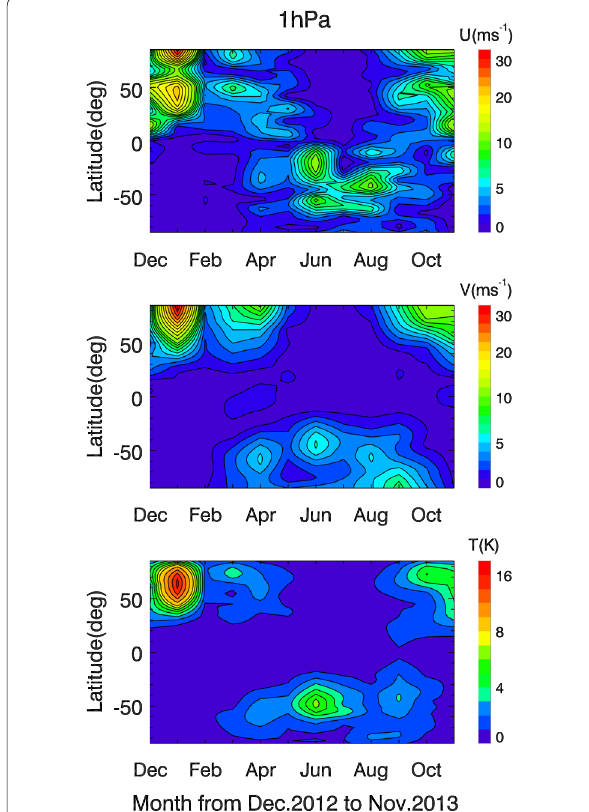
Fig. 3 Latitude versus month-of-year structures of the W1 Q16DW amplitudes for the zonal wind (top), meridional wind (middle) and temperature (bottom) at 1